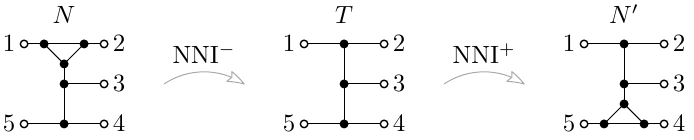
Figure 14: An NNI-sequence from N to N (cid:48) using an NNI + that adds f , an NNI 0 that moves e , and an NNI − that removes e (cid:48) . A shortest NNI 0 -sequence from N to N (cid:48) has length